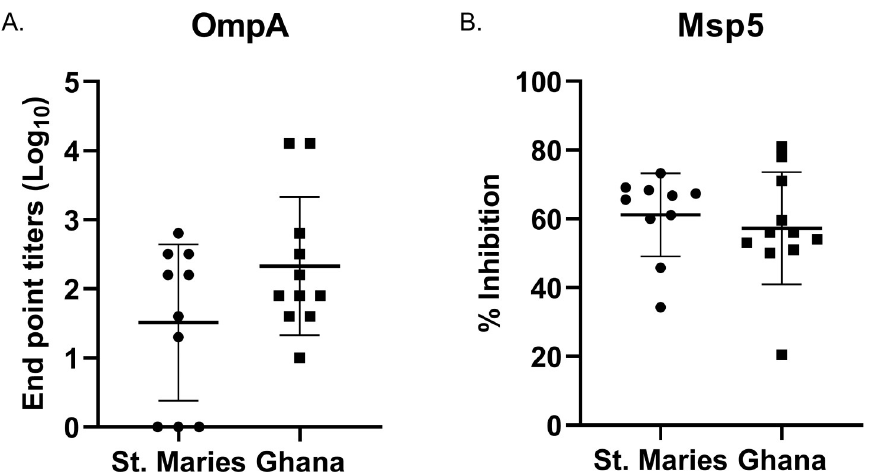
Fig 2. Magnitude of the antibody response directed against A . marginale OmpA V1 and Msp5. A. Anti-OmpA antibody response directed against recombinant OmpA V1 in animals infected with the homologous St. Maries strain or Ghanaian strains. B. Anti-Msp5 antibody response in animals infected with the St. Maries strain or Ghanaian strains of A . marginale . The horizontal bars represent the means of each population. The vertical lines represent the standard